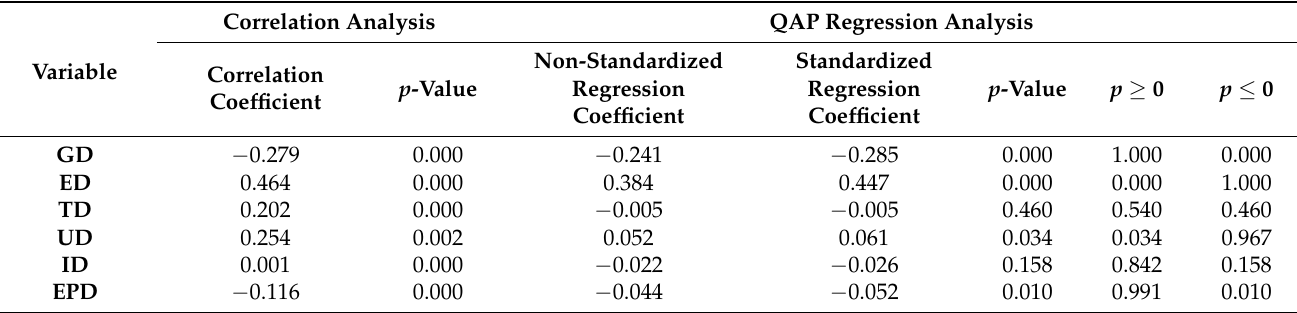
Table 8. Quadratic assignment procedure